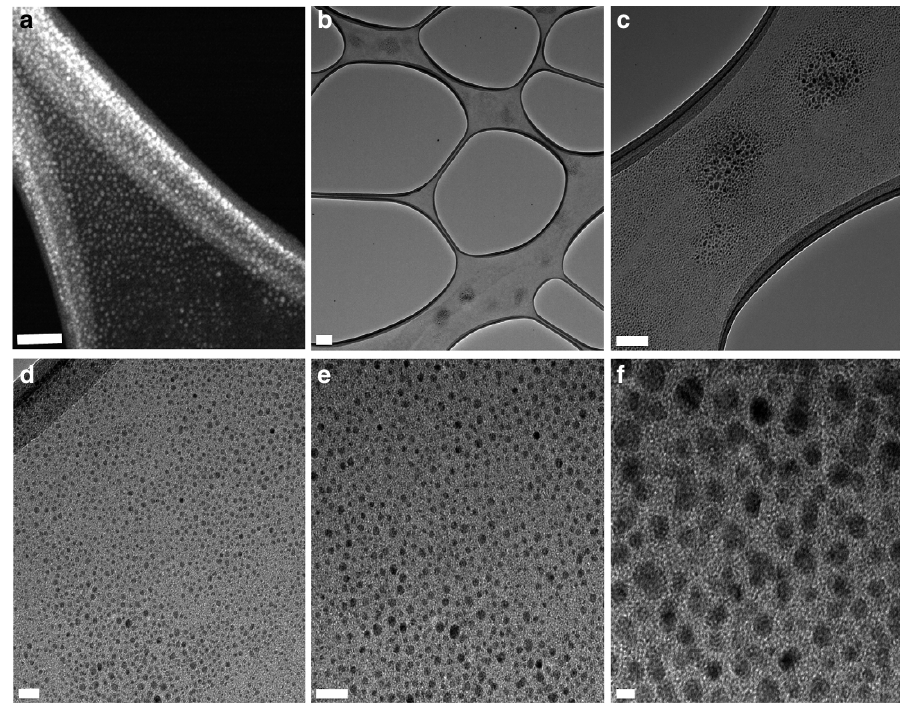
Figure 5 | Electron microscopy of SK-1 whereby SK-1/PPP/CHCl 3 solutions that were drop-casted onto TEM grids. ( a ) Scanning transmission electron micrograph (high angle annular dark field STEM); ( b – f ) Transmission electron micrographs at increasing magnification (bright field TEM). The scale bars equal 100nm ( a ), 200nm ( b ), 100nm ( c ), 20nm ( d , e ), 5nm ( f